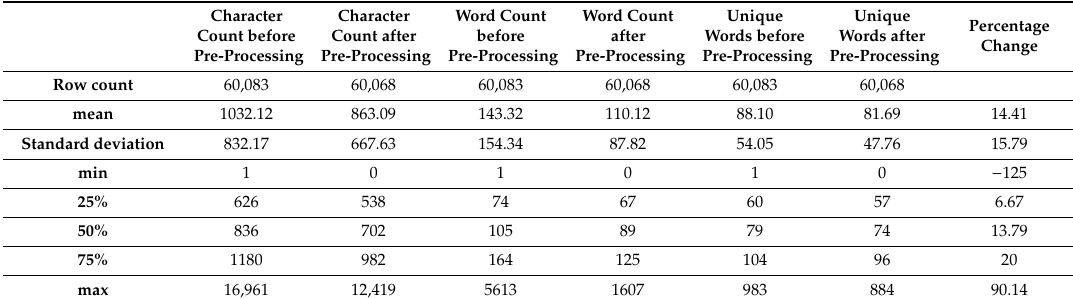
Figure 2. Word cloud for before and after pre-processing of the histopathology reports.